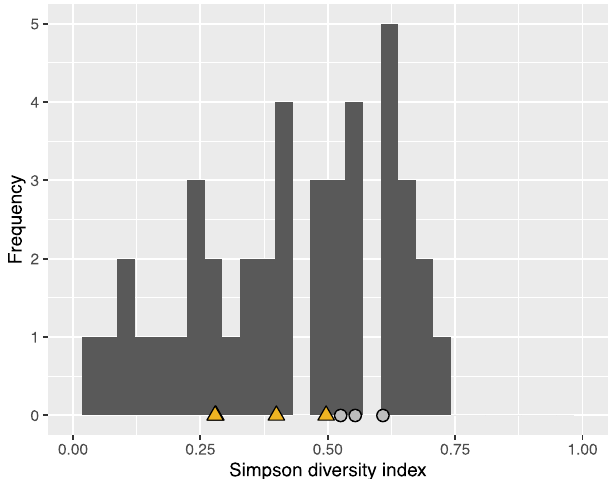
Fig. 5 Histogram of the Simpson diversity index calculated for sub- lineages of lineages 1 – 4. A data set of 17,432 isolates from 74 countries was used to perform this analysis. Yellow triangles designate the Simpson diversity index values of sub-lineages designated as geographically restricted by Stucki et al. Light gray circles designate the Simpson diversity index values of sub-lineages designated as geographically unrestricted by Stucki et al. Source data are provided as a Source Data fi